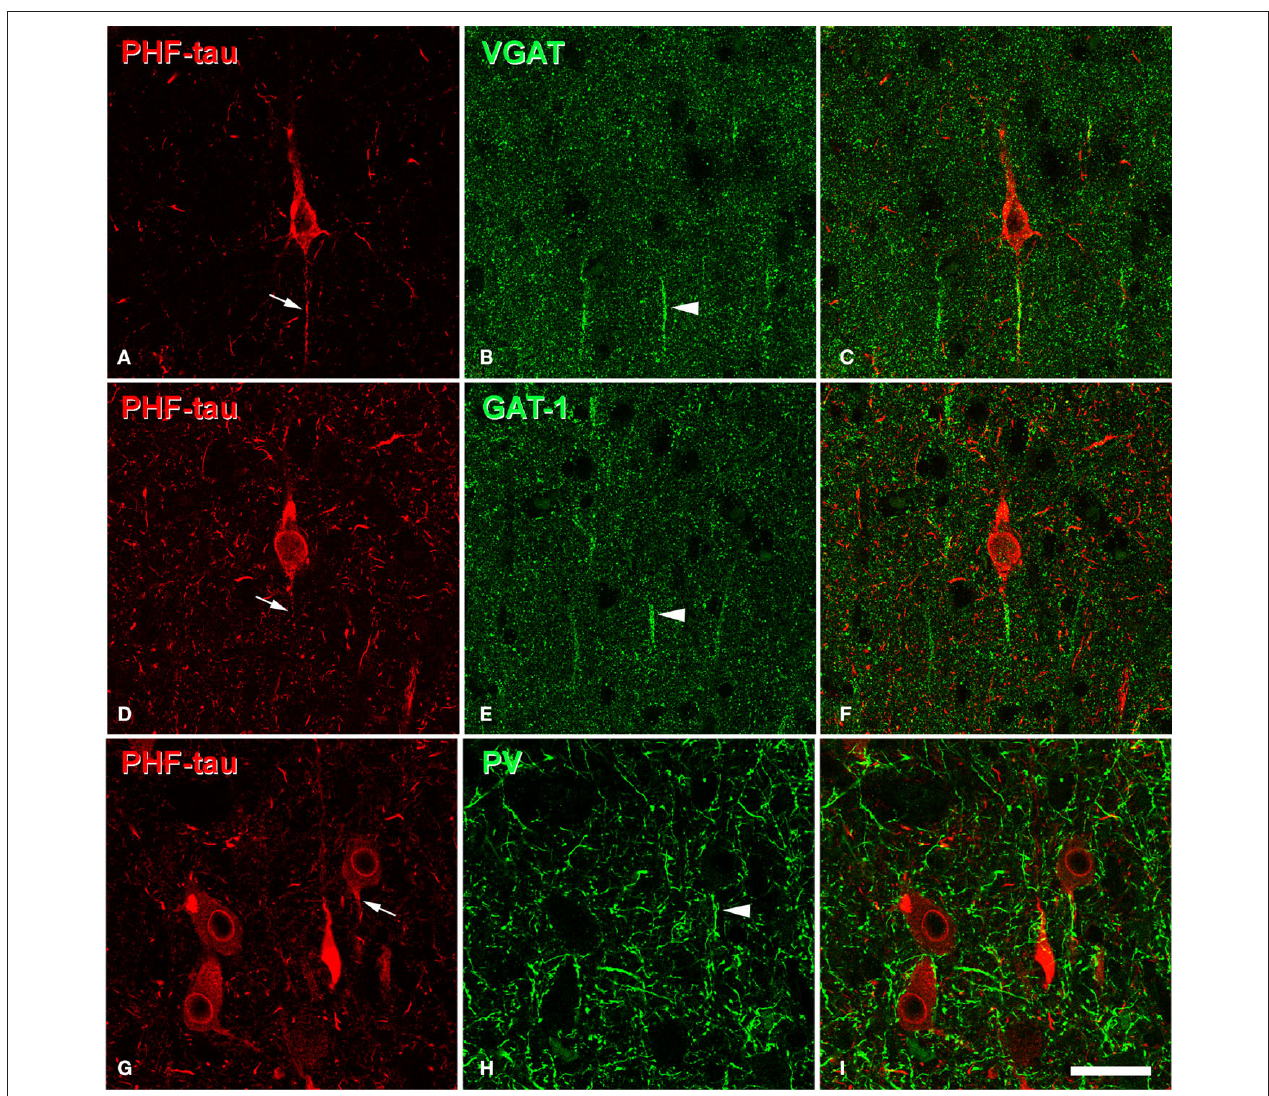
FiGure 12 | (A,B), (D,e), (G,H), pairs of confocal images from the same section and field to illustrate chandelier cell axon terminals (arrowhead) around the axon initial segment (arrow) of PHF-tau-ir neurons (red) with type ii staining in the CA1 field (A,B) and subiculum (D,e) of patient P3, and